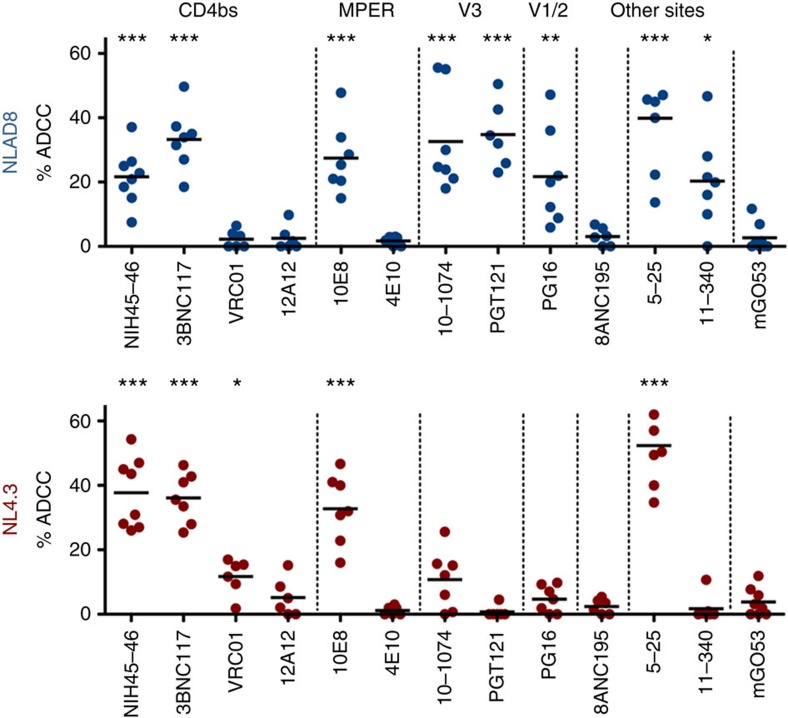
Identification of bNAbs that kill HIV-1-infected lymphocytes.The 12 indicated antibodies were tested at 1.5 μg ml−1 on CEM-NKR cells infected with NLAD8 or NL4.3 strains. ADCC was calculated as the disappearance of Gag+ cells with or without antibody (N=6–8 experiments). Each dot represents a single NK donor. Significance was determined by comparing each antibody to mGO53; ***P<0.001; **P<0.01; *P<0.05, Wilcoxon test).